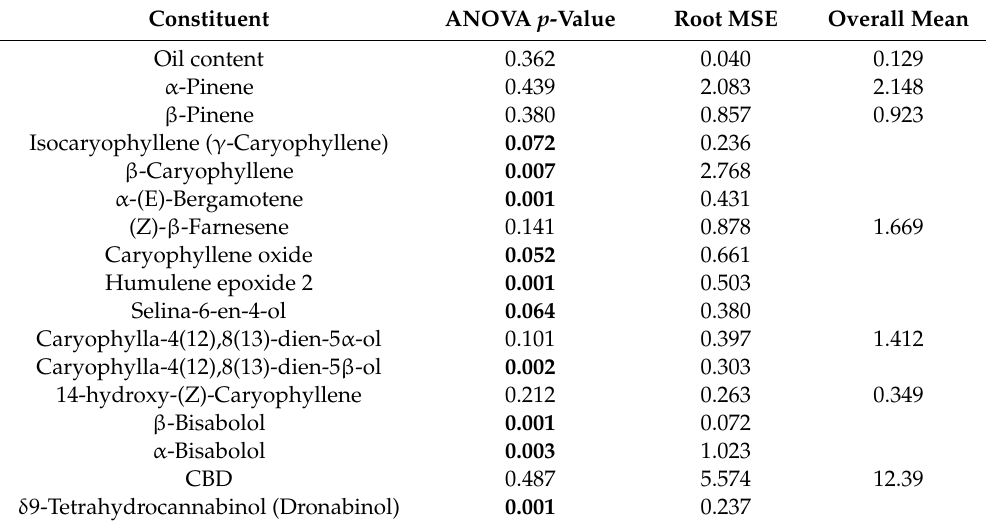
Table 1. Analysis of Variance (ANOVA) p -values that show the significance of the e ff ect of cultivar on 16 constituents, square root of mean squares error (Root MSE) that represents the common standard deviation, and the overall mean oil content ( v / w , volume oil per dry weight) and concentration (%) of the five constituents with no significant di ff erence between the cultivars and CBD. The p -values that show significant ( p < 0.05) and marginally significant (0.05 ≤ p < 0.1) e ff ect and need multiple means comparison are shown in